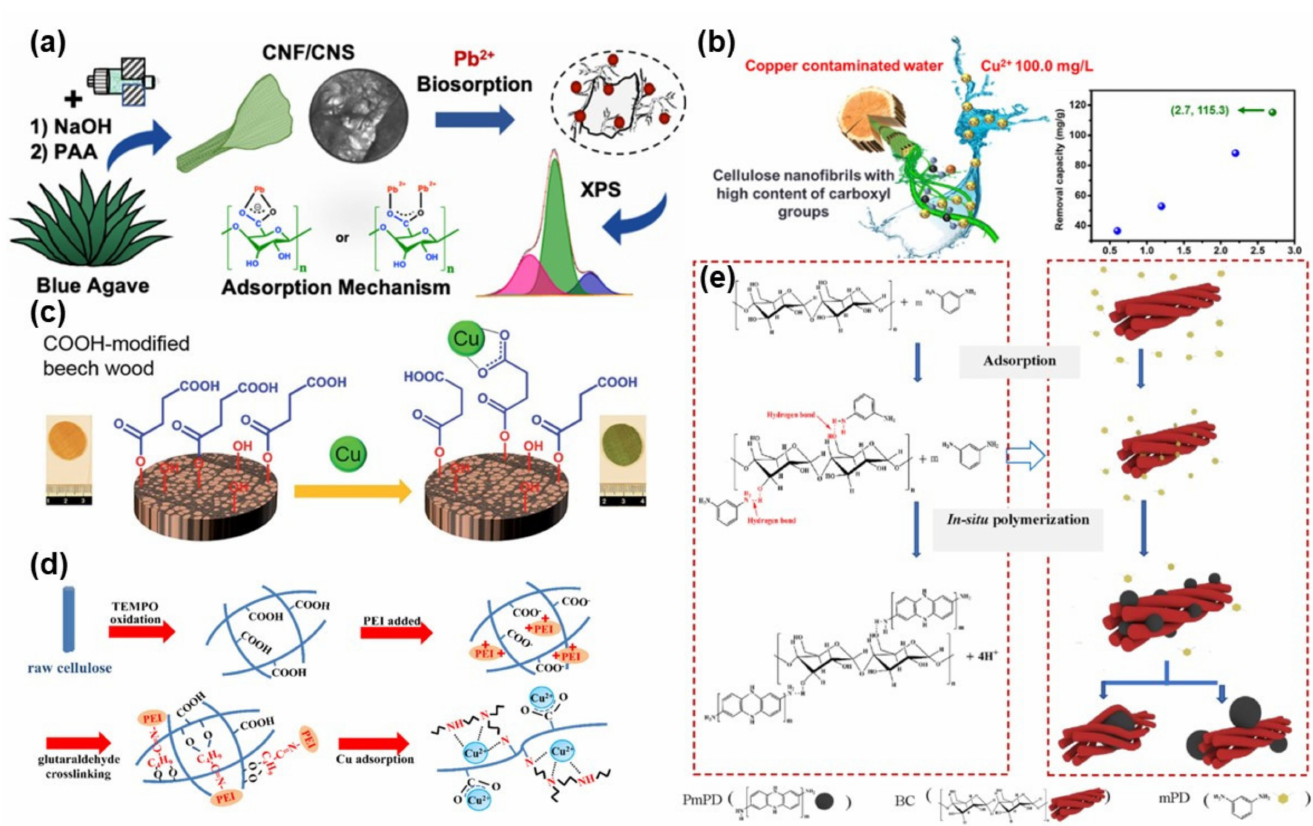
Figure 5. CNF-based nanomaterials for the removal of metal ions: ( a ) Blue agave-derived CNFs/nanosheets for removing Pb 2+ ions. Reprinted with permission from Ref. [64], Copyright 2020, Springer. ( b ) Carboxymethylated CNFs for the removal of Cu 2+ . Reprinted with permission from Ref. [15], Copyright 2019, American Chemical Society. ( c ) Wood-derived CNFs for the removal of Cu 2+ . Reprinted with permission from Ref. [67], Copyright 2019, Royal Society of Chemistry. ( d ) TEMPO oxidization and PEI grafted CNFs for the removal of Cu 2+ . Reprinted with permission from Ref. [69], Copyright 2016, Elsevier Ltd. ( e ) PmPD/CNF materials for the removal of Cd(VI). Reprinted with permission from Ref. [71], Copyright 2018, Elsevier